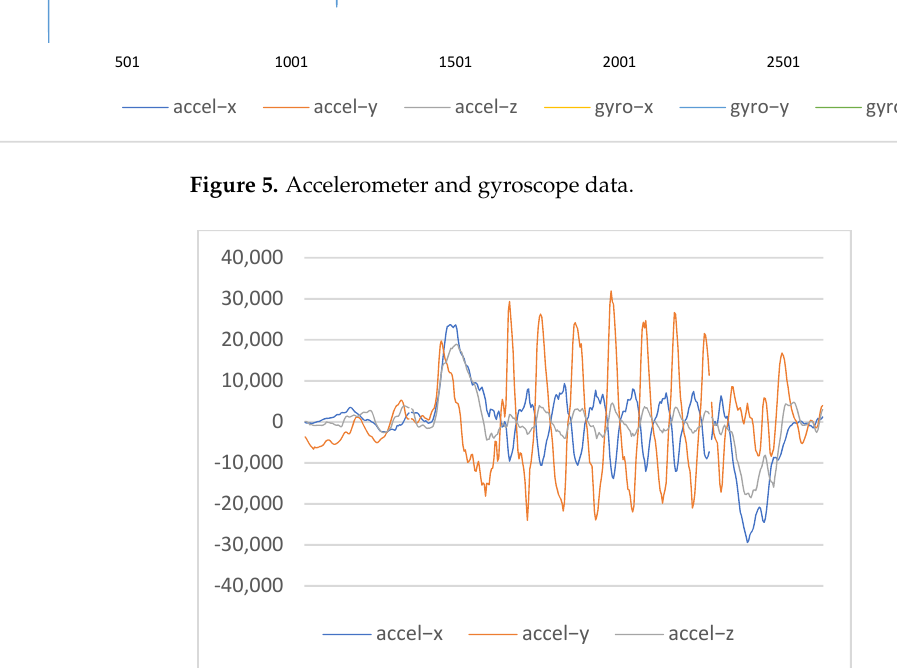
Table 1. Attributes and dataset statistics used in our study.